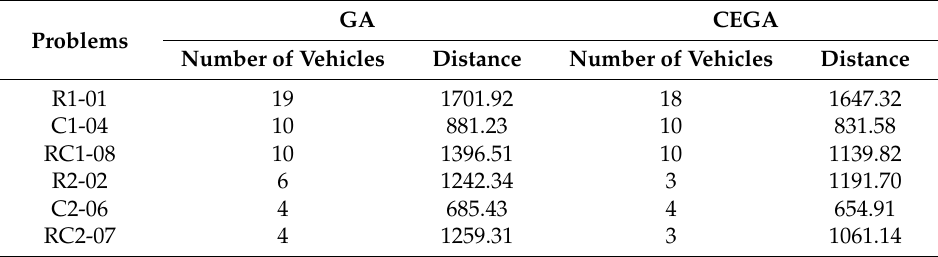
Table 2. Test results of cycle evolutionary genetic algorithm